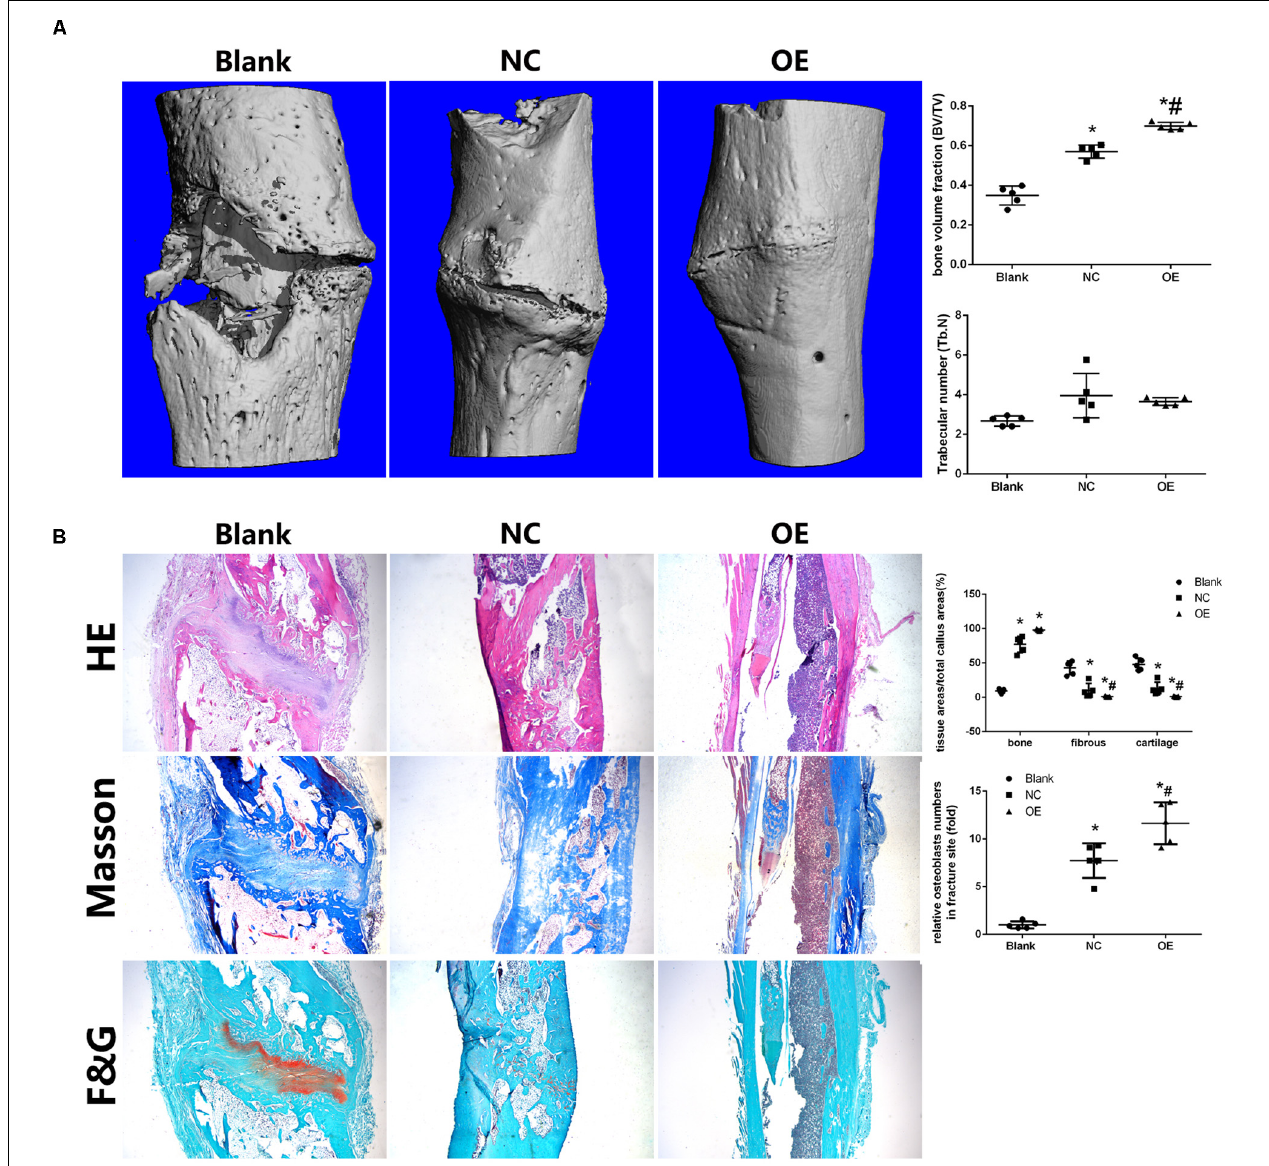
FIGURE 5 | Parkin-overexpressed cell sheets accelerate bone formation in a tibial fracture model in rats. (A) Microcomputed tomography (micro-CT) analysis of bone healing. Bone volume and trabecular thickness were analyzed by micro-CT. Data are expressed as the mean ± SD. * P < 0.05 vs. fractures alone group (Blank). # P < 0.05 vs. fractures with the negative overexpressing-cell sheet (NC). (B) Histologic analysis for bone healing. HE, hematoxylin and eosin staining; Masson, Masson’s trichrome staining, F&G, fast green and Safranin staining. Magnification × 40. Data are expressed as the mean ± SD. * P < 0.05 vs. fractures alone group (Blank). # P < 0.05 vs. fractures with the negative overexpressing-cell sheet